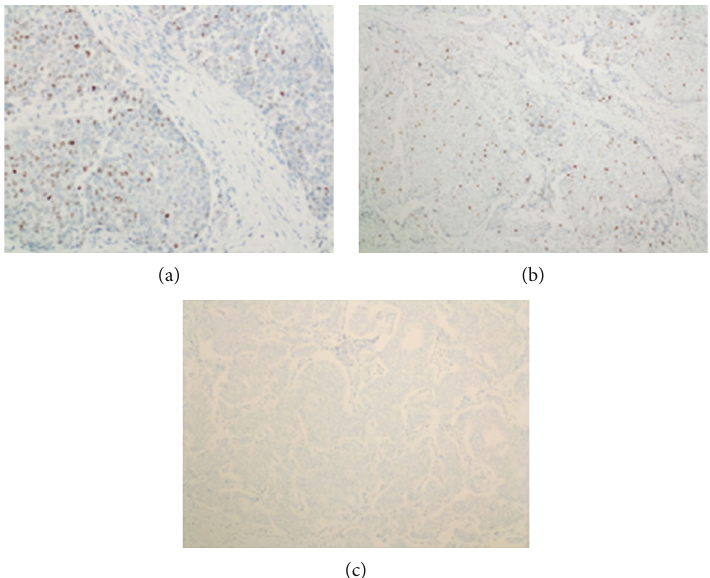
Figure 6: Immunohistochemistry staining of male breast cancer. (a) Progesterone receptor staining was positive in 30% of tumor cells (lower percentage compared to estrogen receptor); magni fi cation, × 200. (b) The Ki-67 proliferative index was 20-30%; magni fi cation, × 100. (c) HER-2 was completely negative; magni fi cation, ×